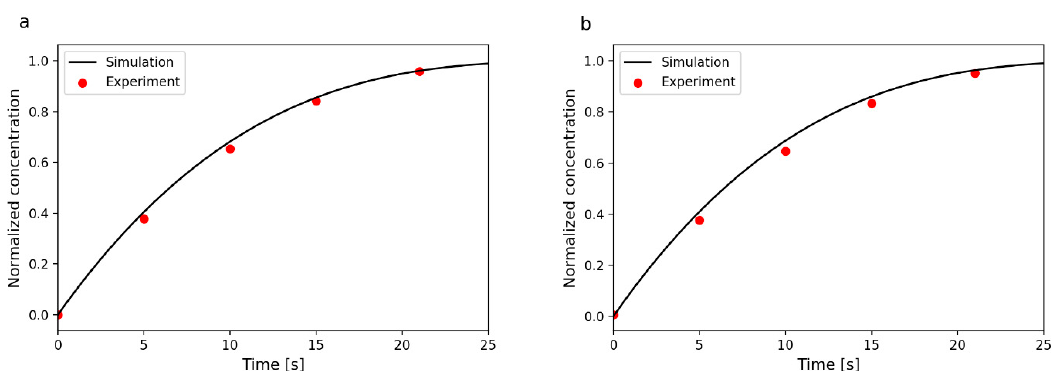
Figure 6. Experimental and simulation of dissolution profile. Right ( b ) is D3 with 150 rpm and left ( a ) is D2 with 150 rpm.